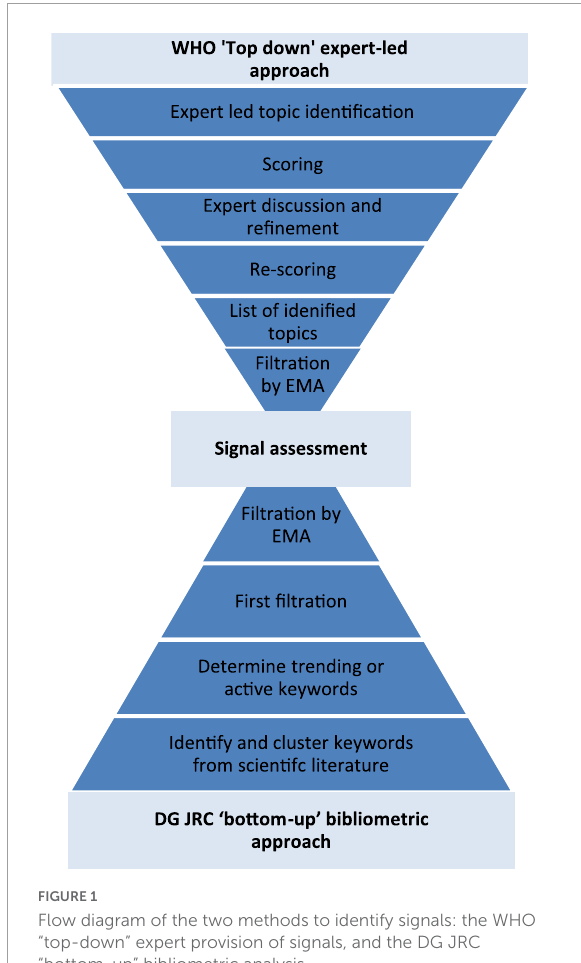
FIGURE1 Flow diagram of the two methods to identify signals: the WHO “top-down” expert provision of signals, and the DG JRC “bottom-up” bibliometric